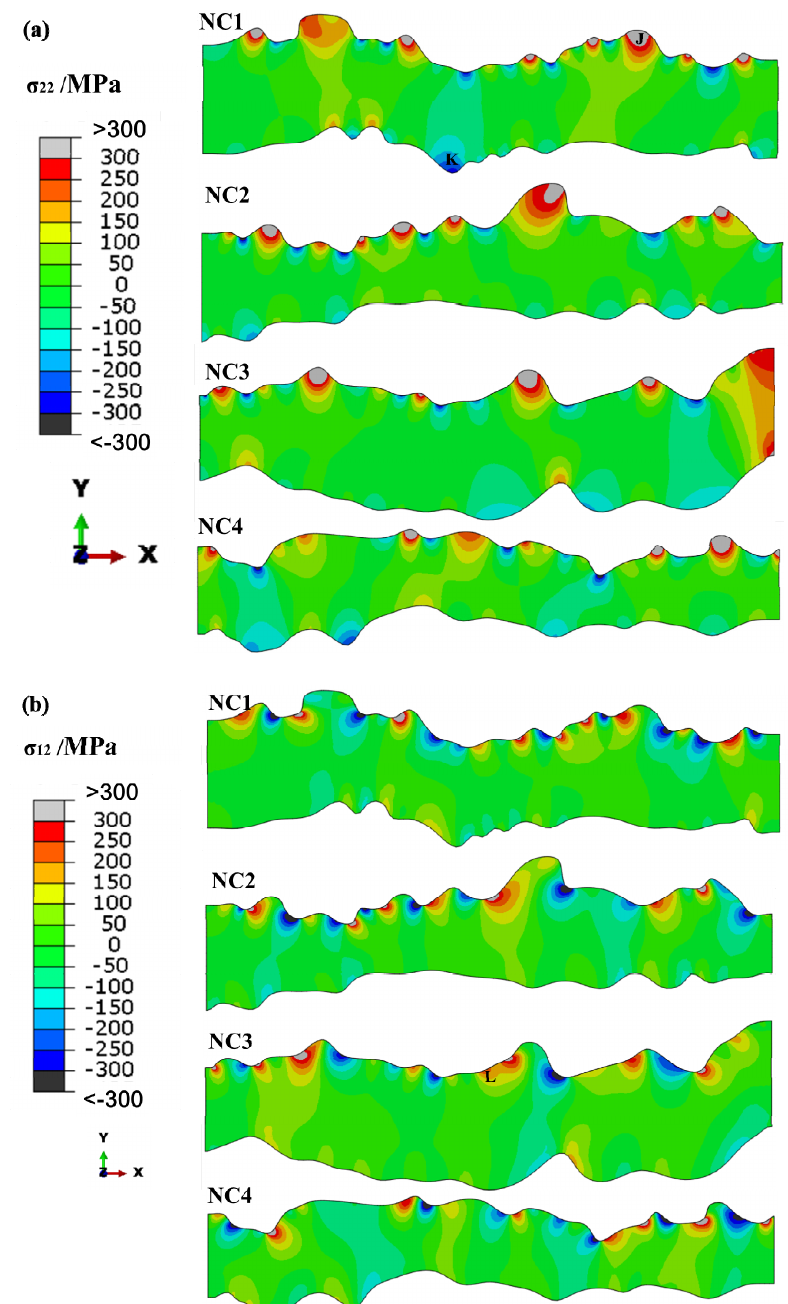
Figure 6. ( a ) σ 22 and ( b ) σ 12 stress distribution in BC.